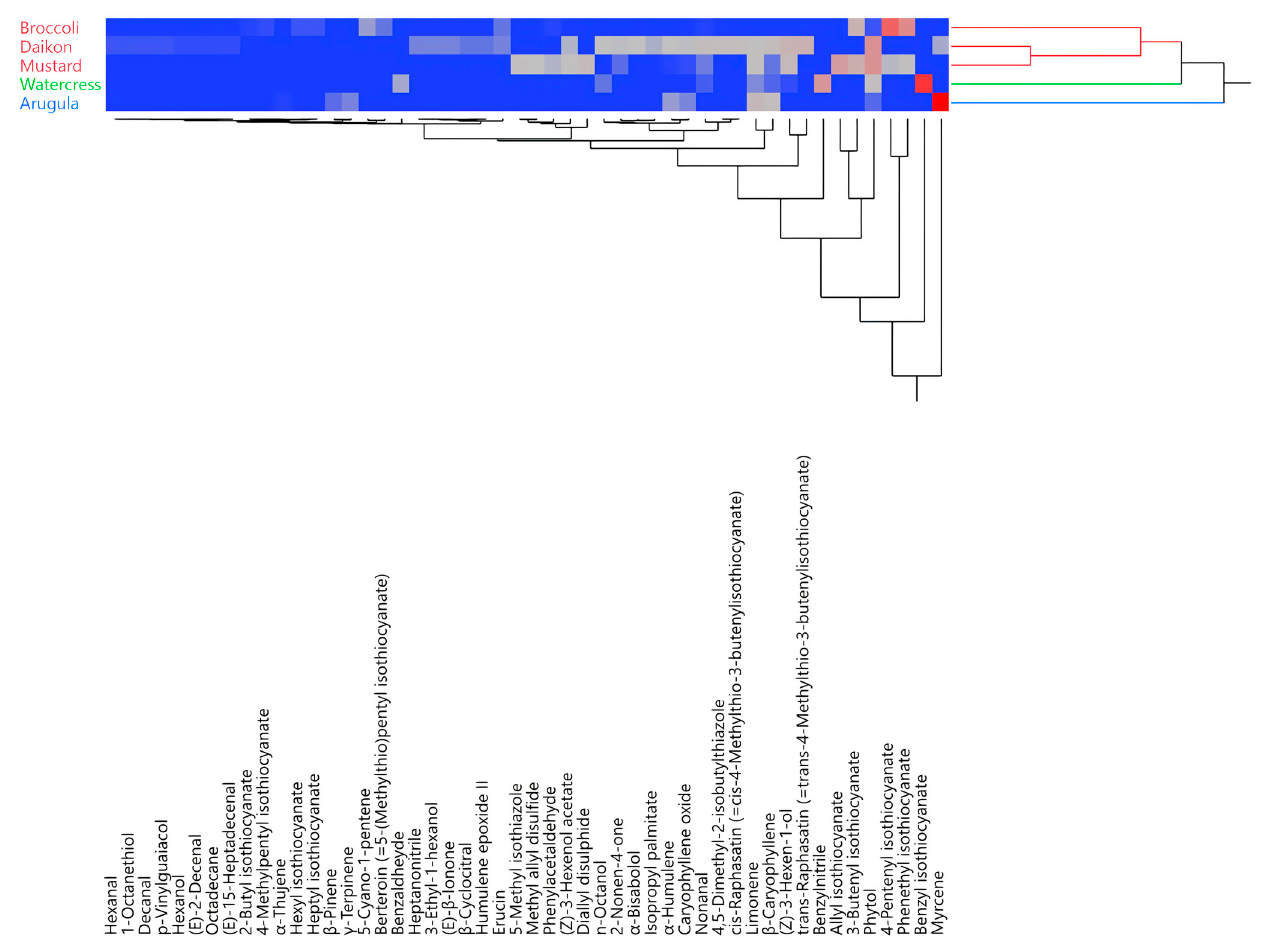
Figure 2. Two-way dendrogram obtained using the hierarchical cluster analysis performed on the complete essential oil (EO) compositions for all of the analyzed species.